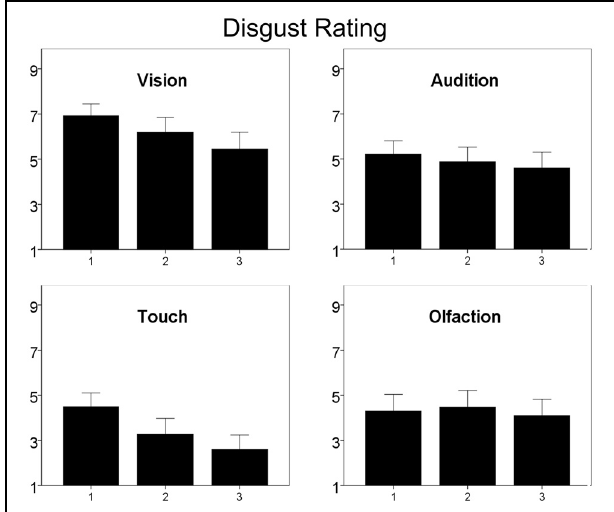
FIGURE 5 | Subjective ratings of disgust with repeated measurement. Ratings are given on a 9-point scale. Higher values represent higher disgust ratings. Note: Only participants ratings for stimuli presented unlabeled are given in order to avoid possible label influences. Error bars indicate 95% confidence